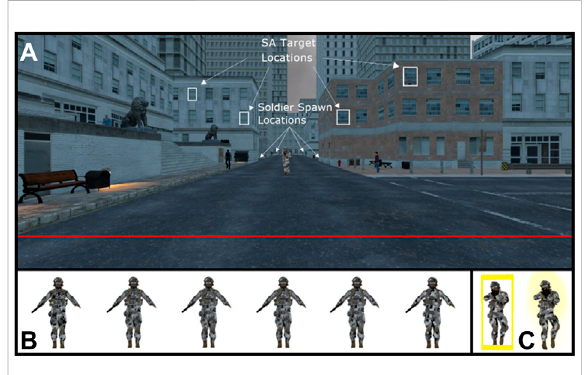
FIGURE 1 (A) ExampletrialoftheDefensiveSecurityTask(DST)fromthe No AiTR condition. We have added arrows depicting the four possible Soldier spawn locations and the four possible SA Target spawn locations. Example SA Target is shown in top-right window. (B) Example Soldier avatars in the six possible blended camou fl age patterns. From left to right, 100% Enemy, 65% Enemy, 51%Enemy,51%Friendly,65%Friendly,100%Friendly. (C) Example AR AiTR overlays. Left side depicts Bounding Box overlay (BB). Right side depicts Soft Highlight overlay